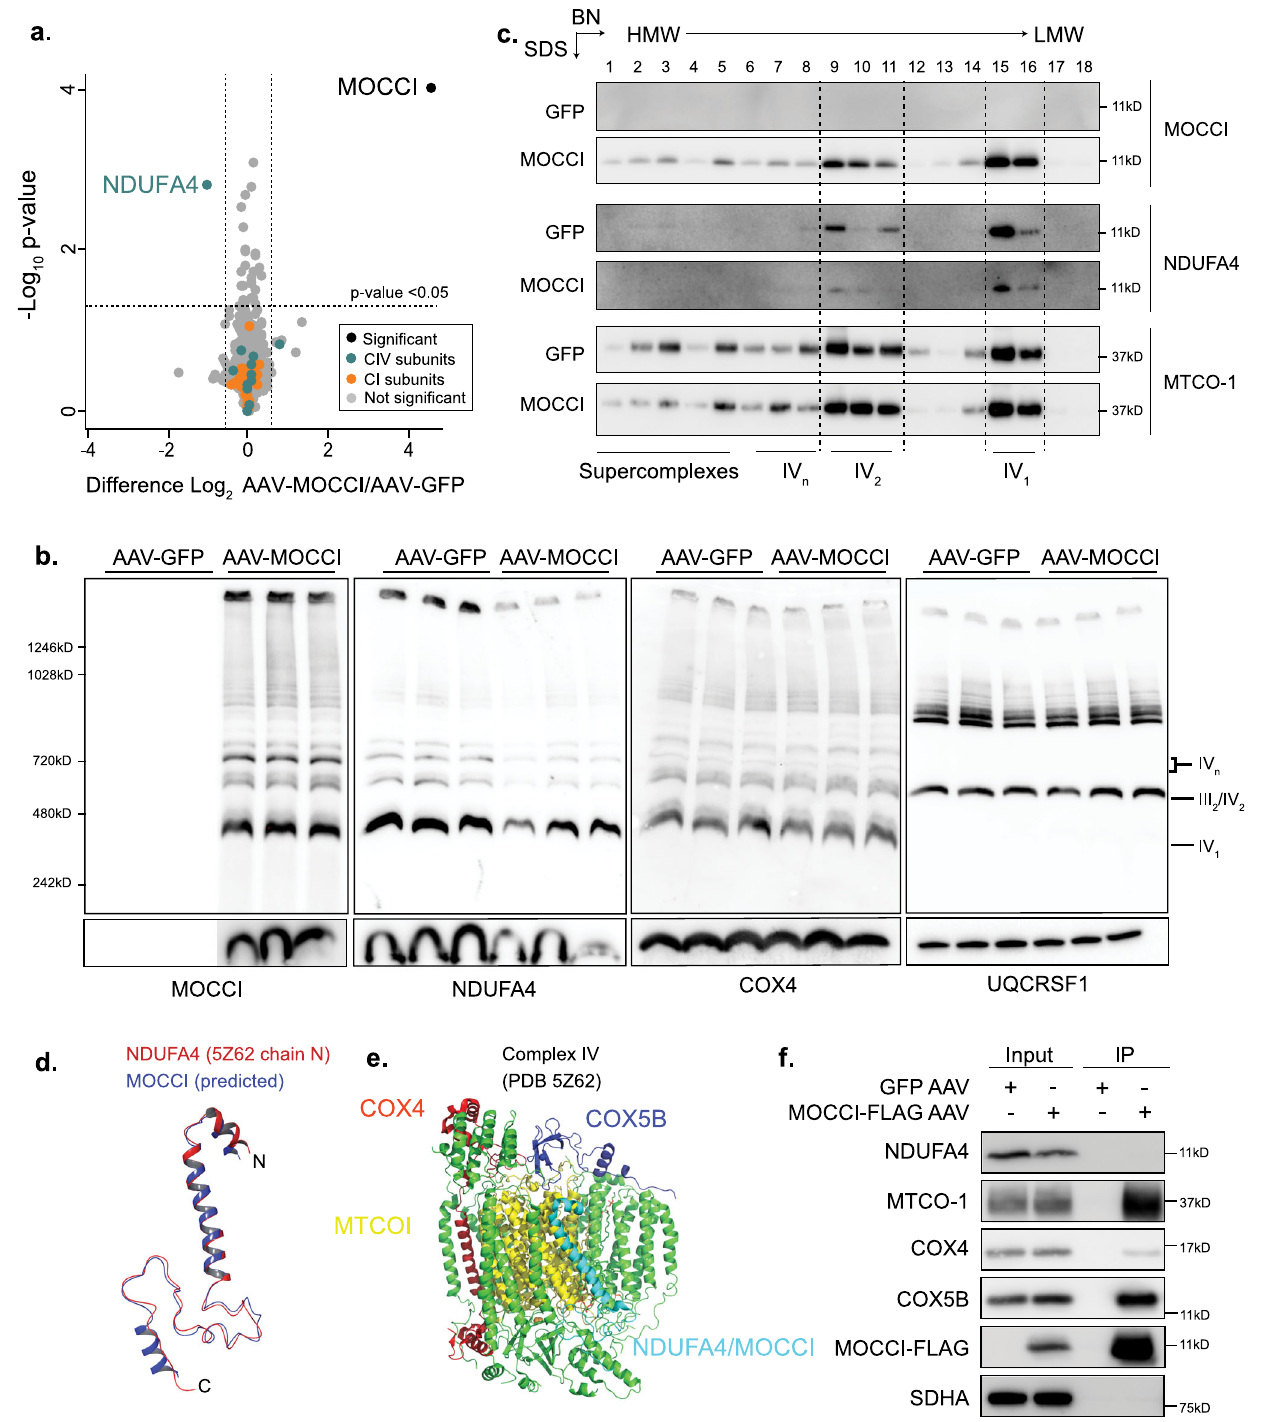
Fig. 4 NDUFA4 is exchanged for MOCCI in Complex IV during in fl ammation. a Volcano plot of proteins detected by quantitative TMT-mass spec in AAV-GFP or AAV-MOCCI mouse heart mitochondria. p = two-tailed Student ’ s t test, n = 3 mice per AAV. b BN-PAGE (top) and SDS-PAGE (bottom) of AAV-MOCCI/GFP mouse heart mitochondria probed for the indicated respiratory chain proteins. Each lane represents mitochondria from one mouse. Quanti fi cation of NDUFA4 shown in Supplementary Fig. 4a. c Two-dimensional BN-SDS-PAGE to show downregulation of NDUFA4 in CIV complexes. n = 3 biological replicates. Source data are provided as a Source Data fi le. d Alignment of the predicted secondary structure of MOCCI (iTASSER model) and known structure of NDUFA4 in Maestro (Schrodinger). e The position of NDUFA4 (ribbon) in CIV cryo-EM structure (PDB 5Z62). All other subunits are depicted in tube representation. MTCO-1 (purple) and the redox centers (HEME-A and Cu 2 + ) are highlighted to illustrate the relative position of NDUFA4. f Co-IP of NDUFA4 and MOCCI. Digitonin (1%)-solubilized isolated mouse heart mitochondria were immunoprecipitated with anti-FLAG and probed for the proteins as indicated. AAV-GFP served as negative control. Source data are provided as a Source Data fi